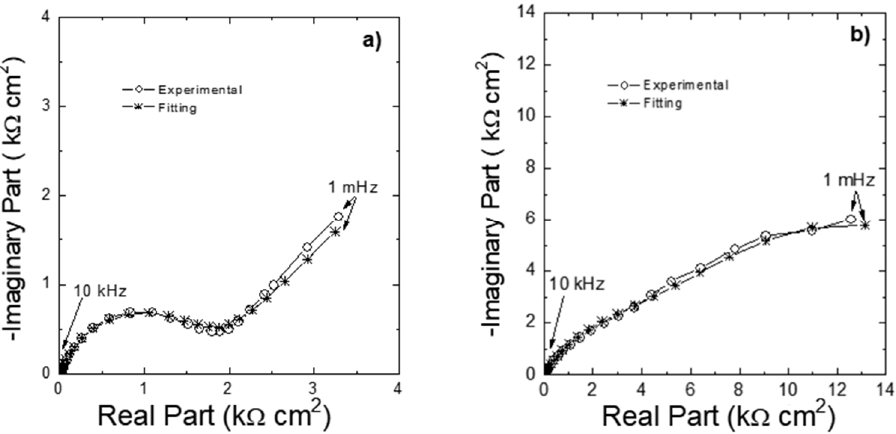
Figure 15. Measured ( ○ ) and fitted (*) Nyquist plots for a B (as-cast) sample ( a ) at 24 h of immersion and ( b ) at 192 h of immersion (b).